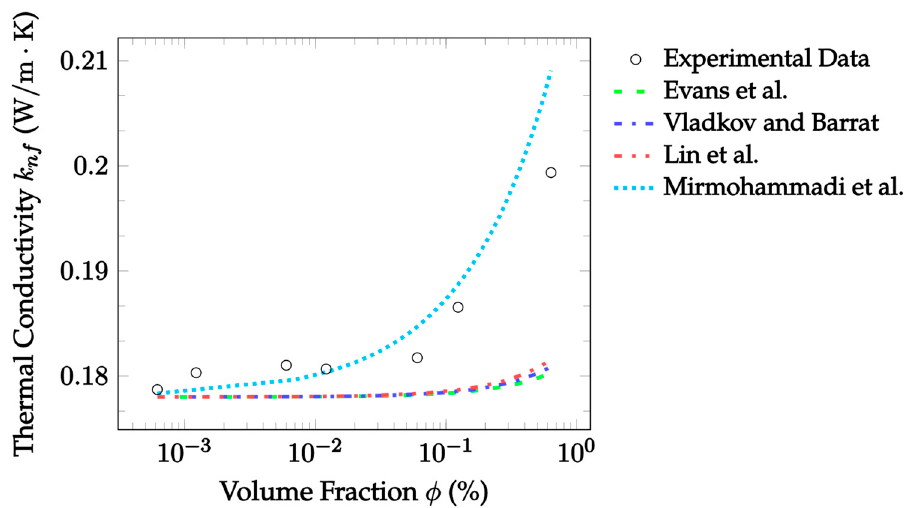
Figure 10. Molecular dynamics simulation predictions compared to experimental data for CuO nanoparticles in ethanol at T = 300 K, for volume fractions between 6.18 × 10 − 4 and 0.637%. Experimental data [78], Evans et al. [33], Vladkov and Barrat [34], Lin et al. [35], Mirmohammadi et al. [36].